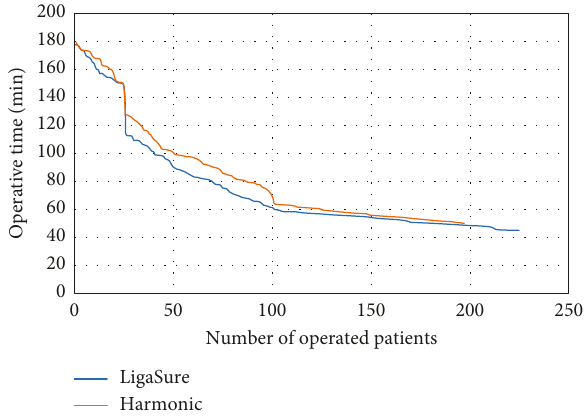
Figure 2: Differences in operative time between Harmonic ® and LigaSure ™